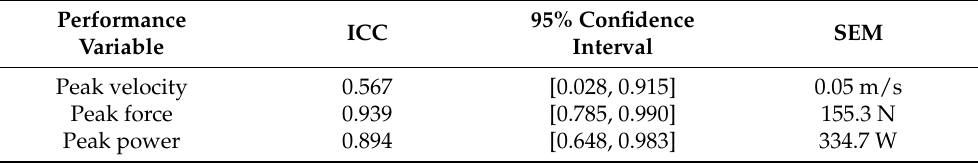
Table 3. Reliability statistics of the